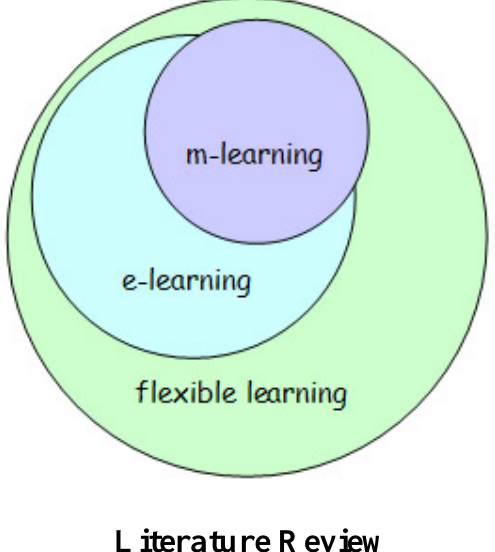
Figure 1. The ‘just enough, just in time, just for me’ model of flexible